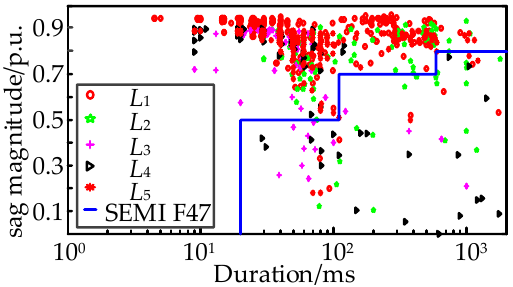
Figure 8. Scatter plot of the measured voltage sags of L 1 ~ L 5 and the SEMI F47 characteristic.